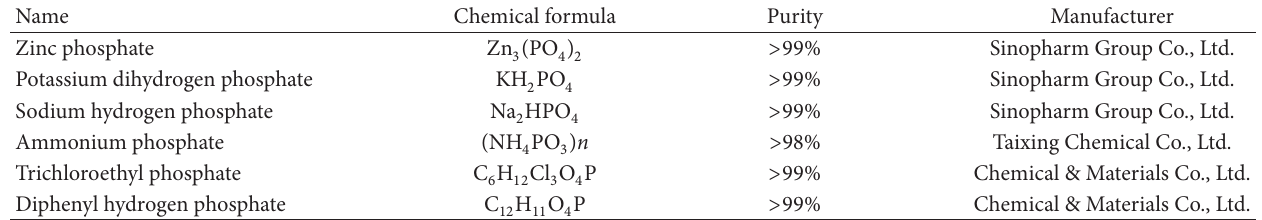
Table 2: Additives used in the